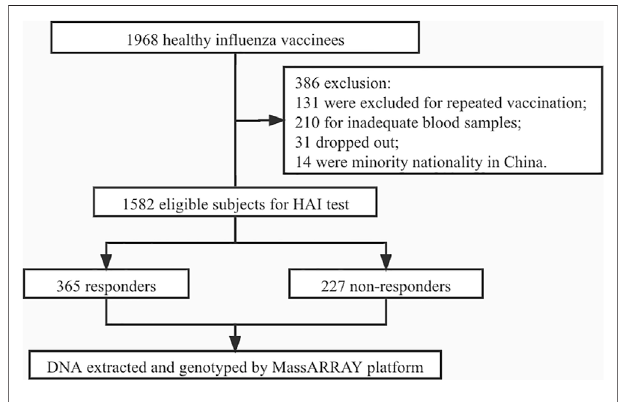
FIGURE 1 | Flow chart.